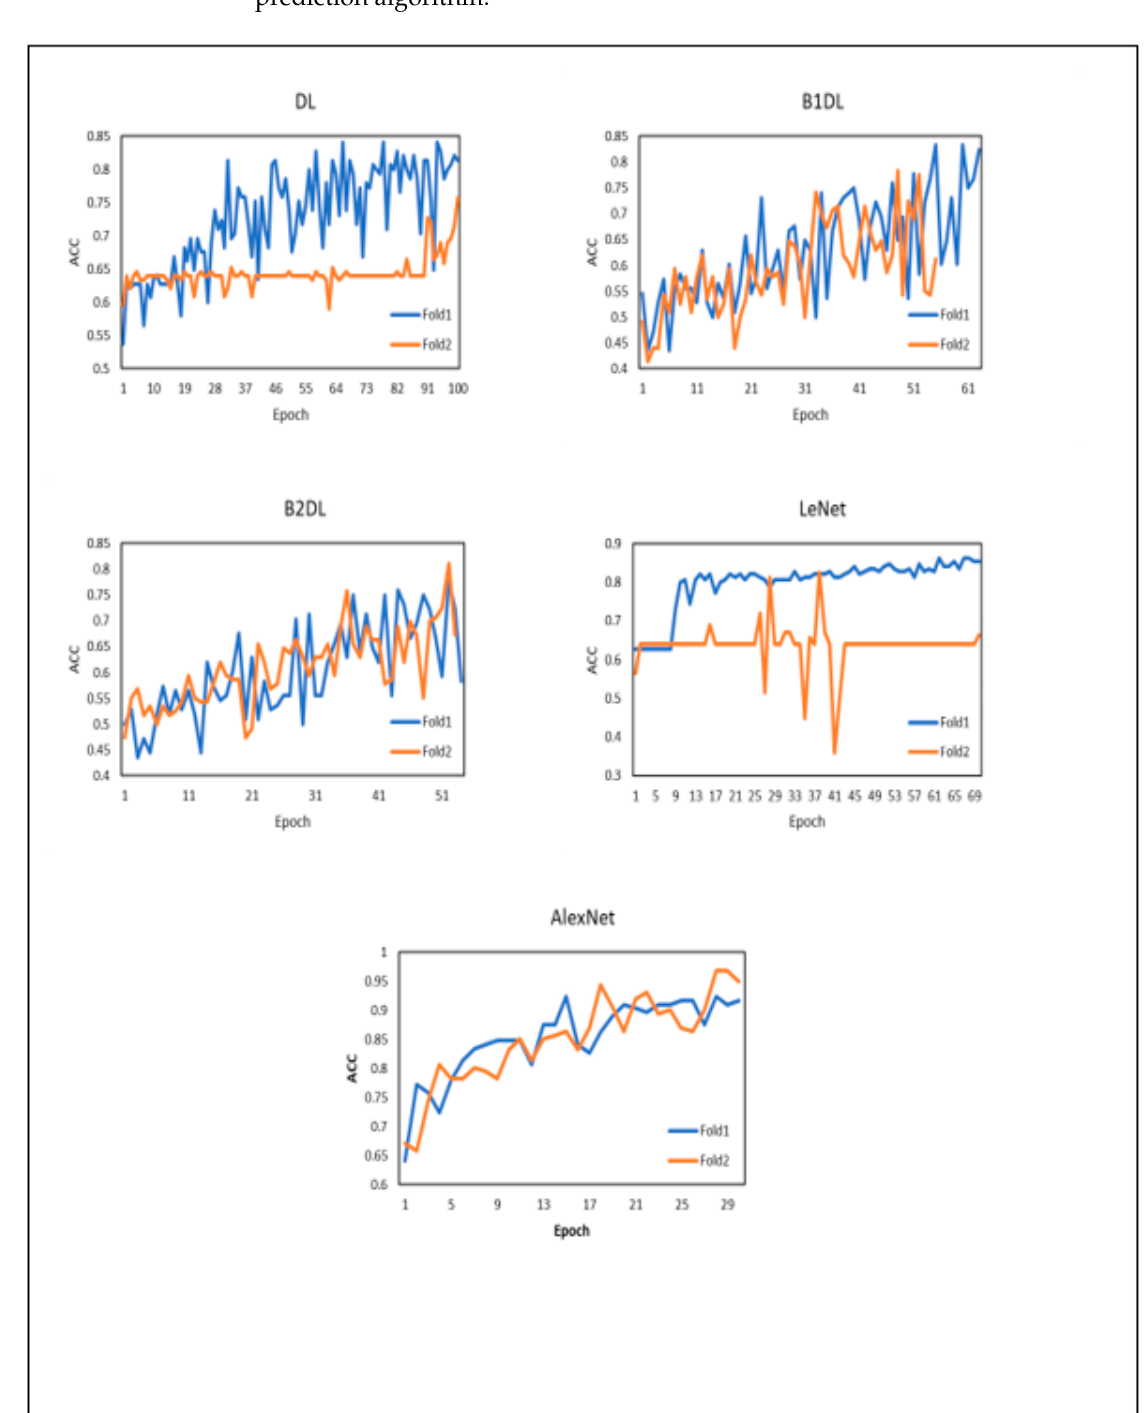
Figure 6. Training accuracy plots for different deep learning approaches when running two-fold cross-validation. ACC denotes the accuracy.